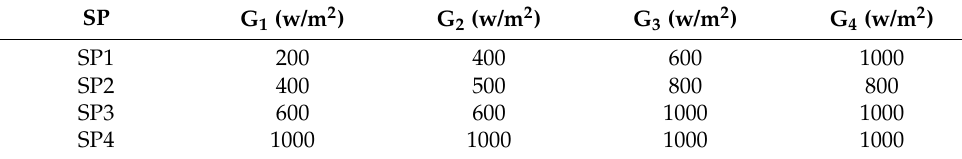
Table 5. SP for P-V and I-V curves.